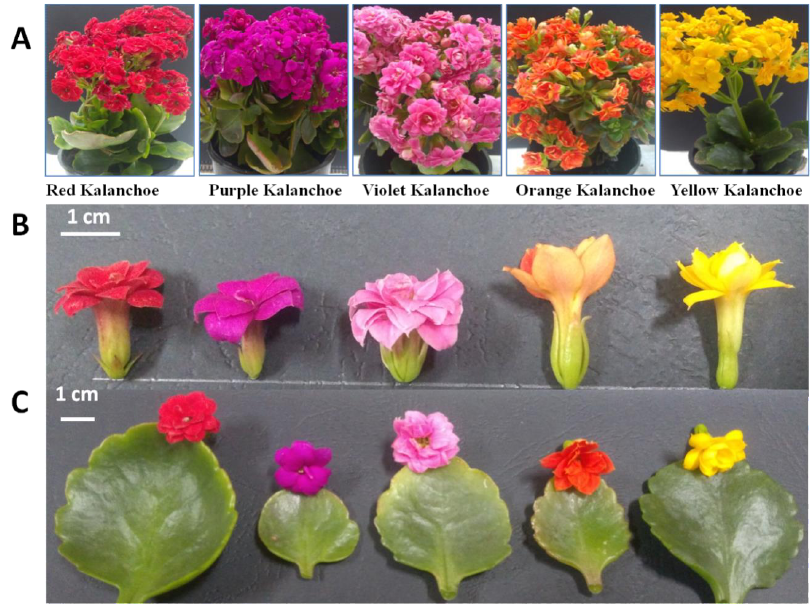
Figure 1. Morphological characterization of five kalanchoe ( Kalanchoe blossfeldiana ) genotypes. ( A ). Different kalanchoe plants with various colors illustrate plant architecture. ( B ). Flower colors polymorphism. ( C ). Difference in leaf shape and size.